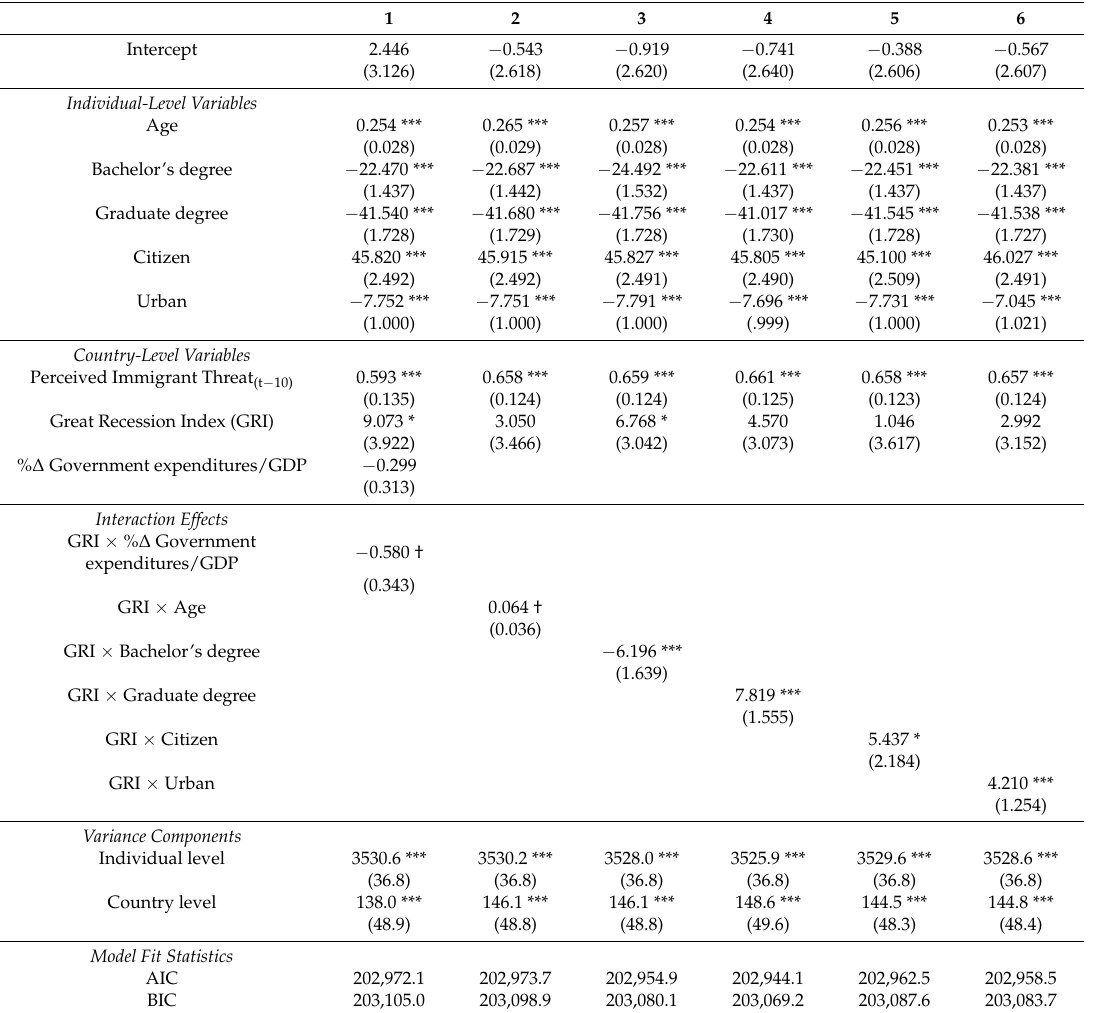
Table 7. Interaction effects for perceived immigrant threat. ( n = 18,433 individuals nested within 22 countries).